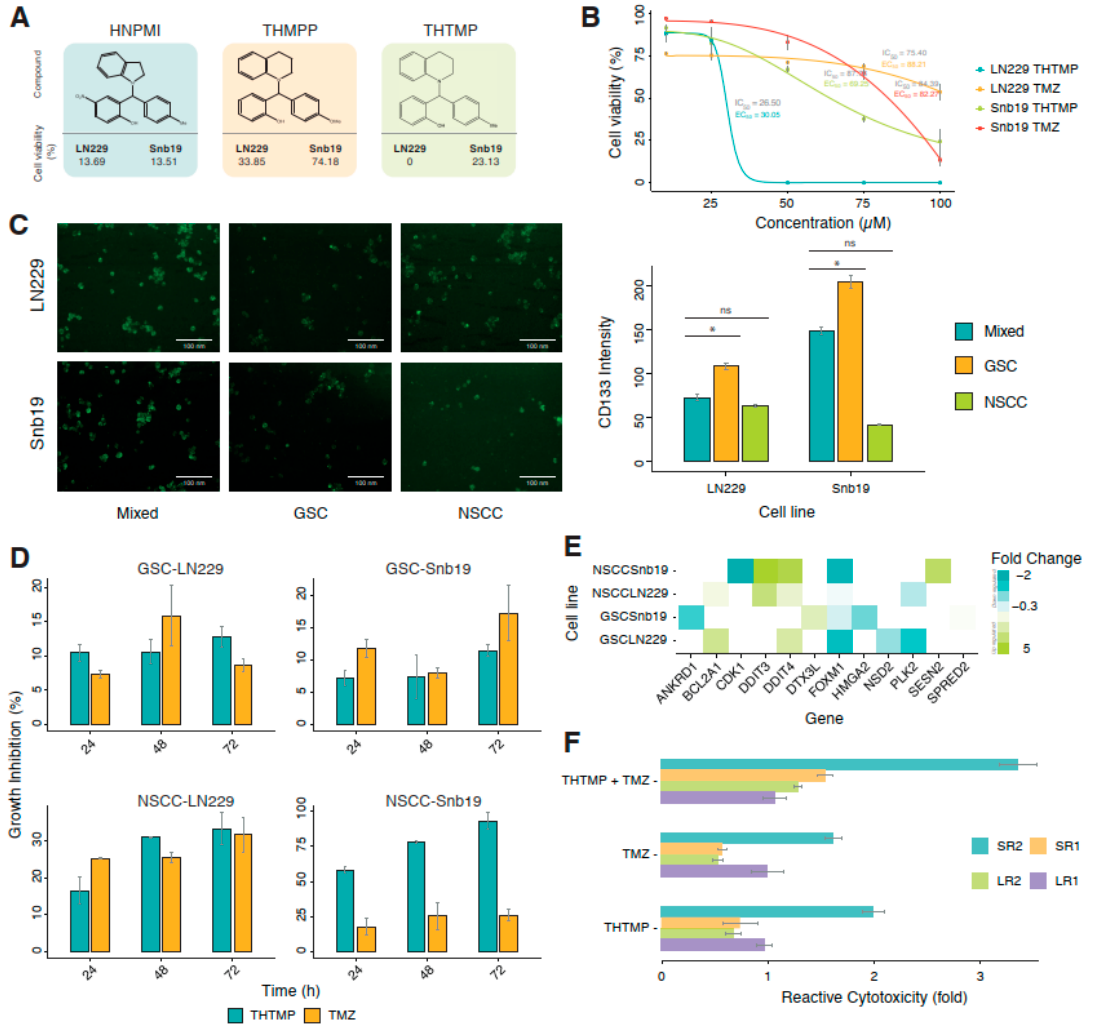
Figure 1. Effect of 3,4-Dihydroquinolin-1(2 H )-yl)( p -tolyl)methyl)phenol (THTMP) treatment on cell survival in GBM cells. ( A ) Molecular structure of three tested alkylaminophenols (HNPMI, THMPP and THTMP) and % cell viability of those compounds on LN229 and SNB19 cell lines at 100 µM concentration. ( B ) Percentage of cell viability for LN229 and SNB19 cell lines upon treatment with THTMP/TMZ in the dilution series from 10 µM to 100 µM. ( C ) Representative image and intensity of CD133 on GSC, NSCC and mixed population of LN229 and SNB19. ( D ) Time-dependent effect of THTMP on GSC and NSCC cells. The results were normalized to DMSO control. One-way ANOVA was conducted ( P < 0.05) to determine the statistical significance in all the conditions compared to DMSO control. ( E ) The top DEGs involved in DNA damage on GSC-LN229, GSC-SNB19, NSCC-LN229 and NSCC-SNB19. The DEGs were color coded corresponding to the up- and down- expressed genes. ( F ) Relative cytotoxicity of resistant variants, LR1, LR2 (derived from GSC-LN229) and SR1, SR2 (derived from GSC-SNB19) to THTMP and/or TMZ. The results were normalized to DMSO control. One-way ANOVA was done ( P < 0.05) to determine the statistical significance in all the conditions compared to DMSO control. All experiments were performed with N = 5. * P < 0.05, ns—non significant.